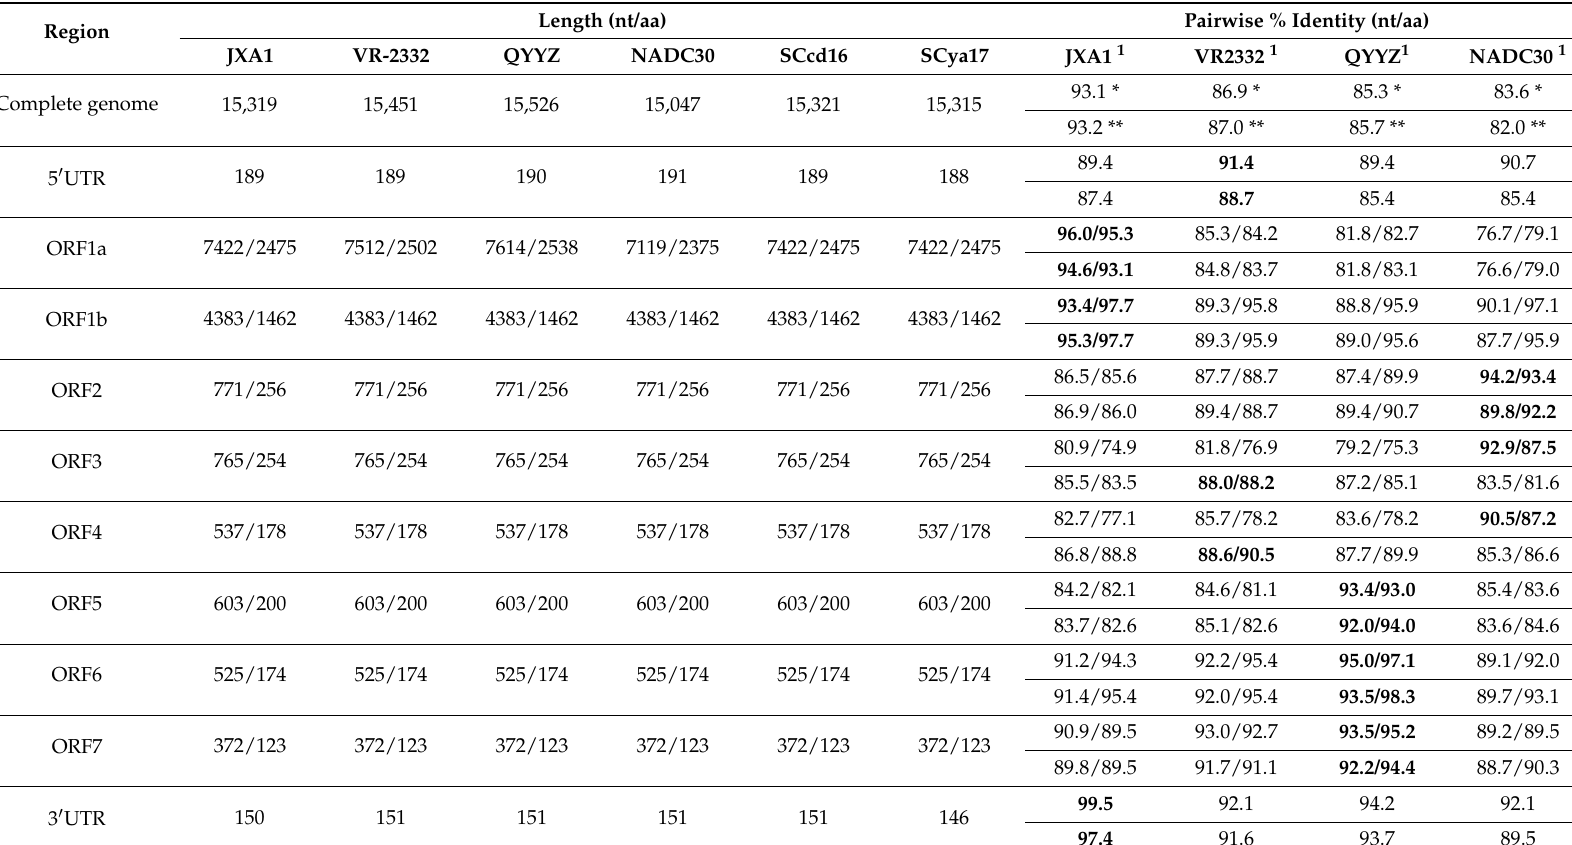
Table 1. Genome positions, protein sizes, and nucleotide and amino acid identities of different regions of SCcd16 and SCya17 compared with other PRRSV-2 representative